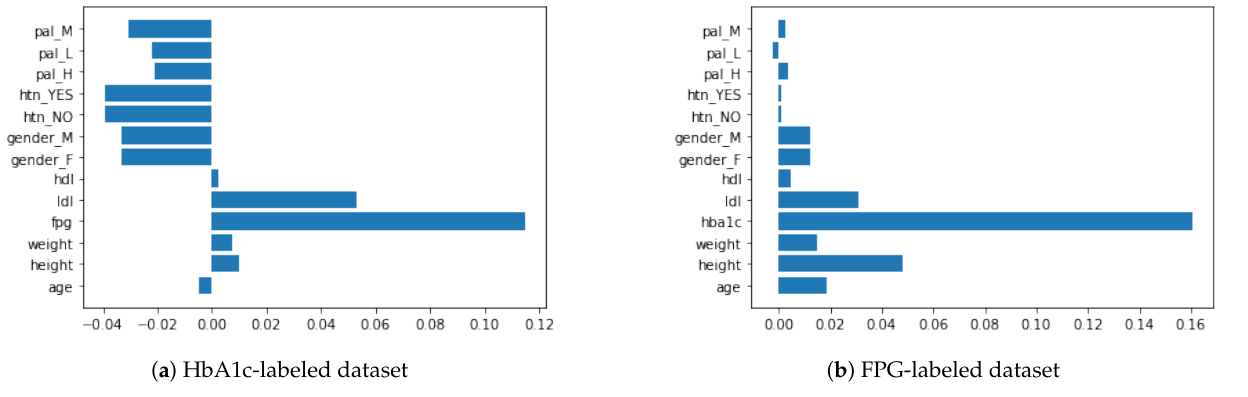
Figure 1. Permutation importance applied to the 9 features in HbA1c- and FPG-labeled